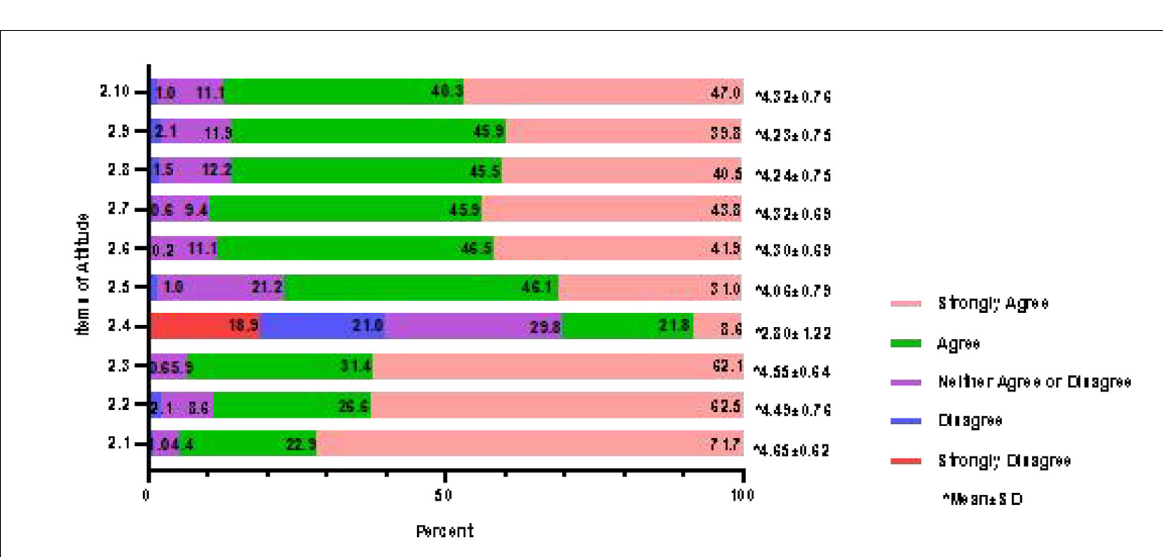
FIGURE3 Attitude score of delirium and subtype assessment for clinical nurses ( n =